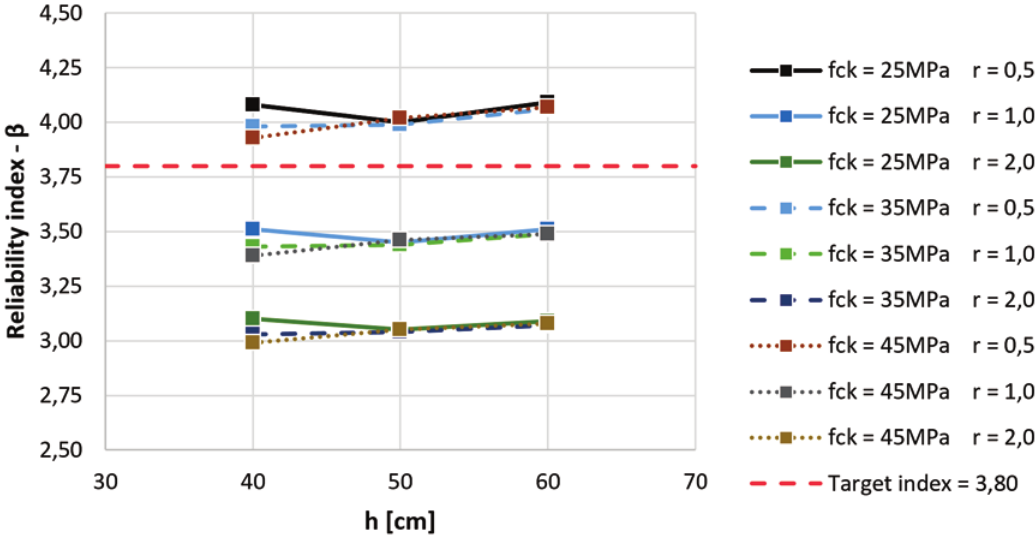
Figure 7.4 Variation of the reliability index as a function of h (pk =